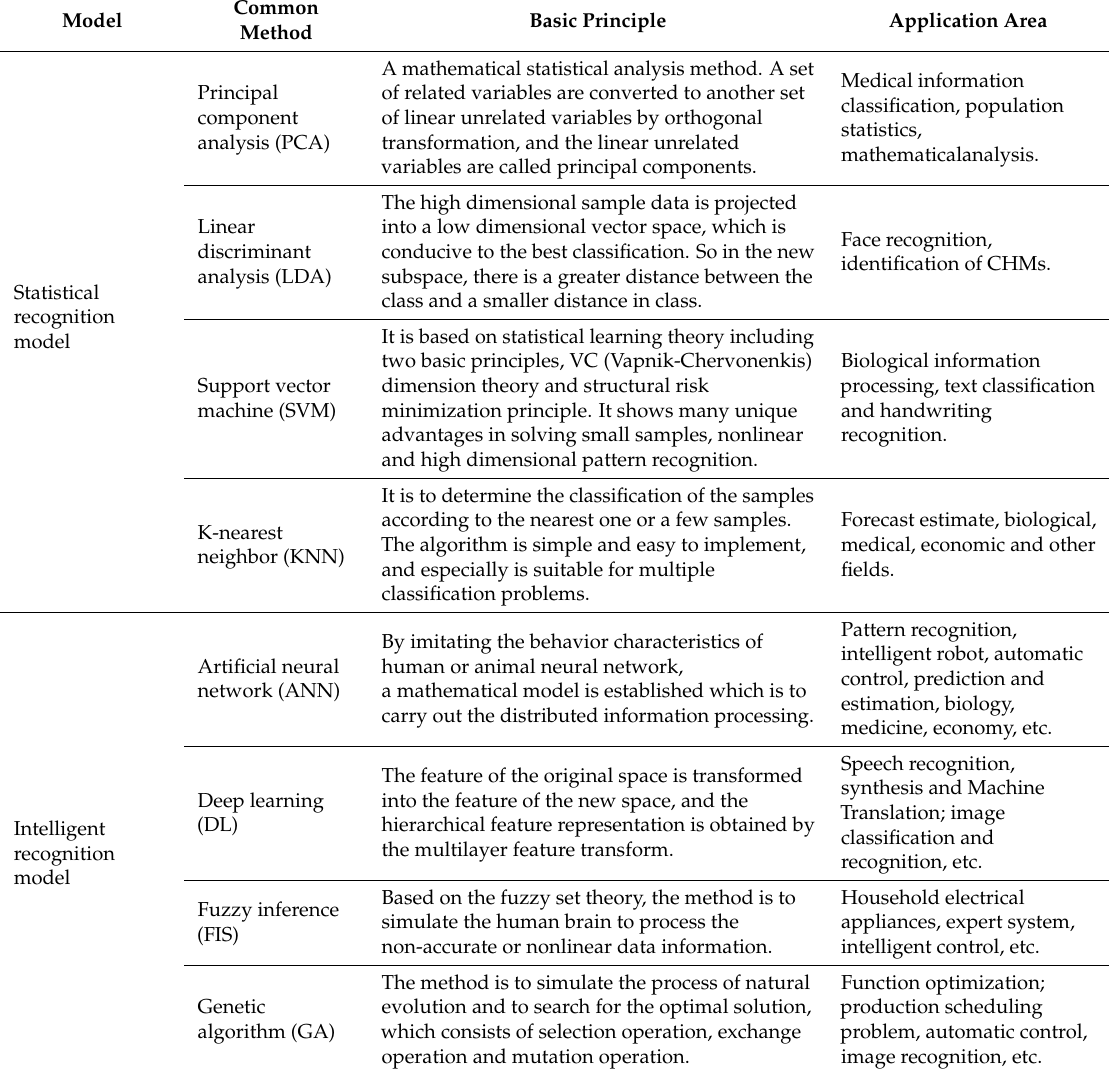
Table 5. Common pattern recognition methods for E-nose